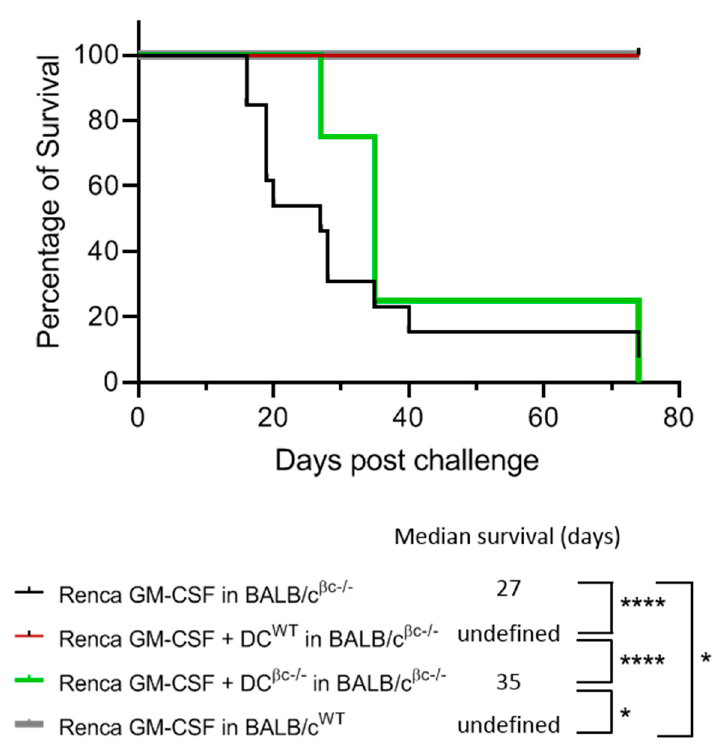
Figure 5. Immunization of BALB/c β c-/- mice with a combination of DC WT and Renca-GM-CSF cells restores the protective anti-tumoral response. DC WT ( n = 13) or DC β c-/- ( n = 4) were pulsed with OVA peptide and injected in BALB/c β c-/- mice. BALB/c WT ( n = 4) and BALB/c β c-/- mice ( n = 13) immunized with only RENCA-GM-CSF were used as positive and negative controls, respectively. Eight days after, the mice were challenged with a contro-lateral s.c. injection of live Renca tumor cells. Following the injection, the mice were monitored for survival and were sacrificed when tumors ulcerated or reached 10 mm in diameter. The survival of the animals was plotted as a Kaplan–Meier curve for each group and analyzed by the log rank-survival test. Differences regarded as statistically significant between the groups are presented as follows: * p < 0.05, ** p < 0.01, *** p < 0.001 and **** p < 0.0001.